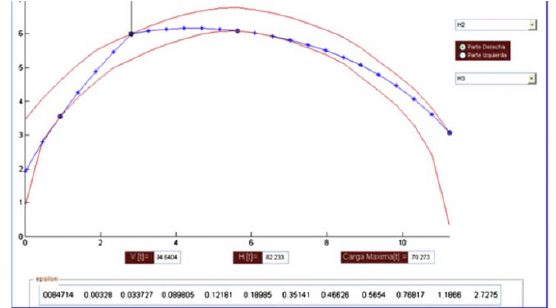
Figure 3. Results of structural analysis in the second arch of Cernadela Bridge (Riveiro et al, 2011).